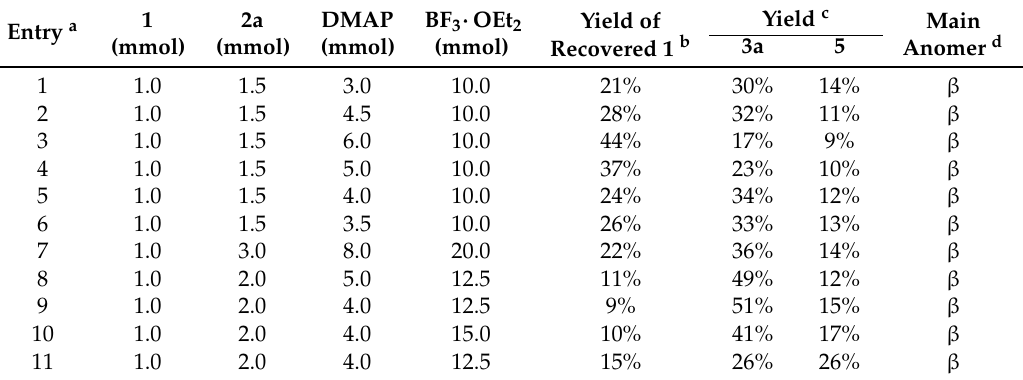
Figure 1. 4-methylumbelliferyl acetate (by-product 5 ). Table 2. Further optimization of conditions for synthesis of the protected β - D -glucopyranuronide ( 3a ).